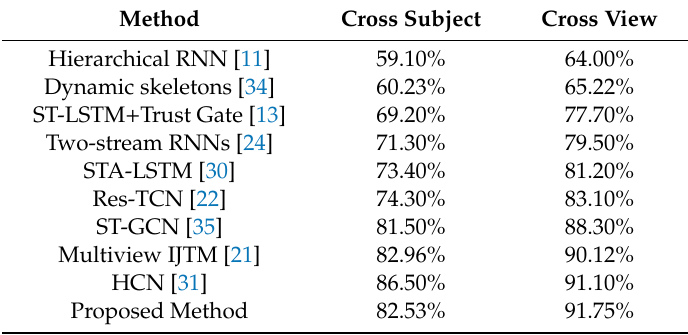
Table 3. Performance comparison of di ff erent methods on NTU RGB + D